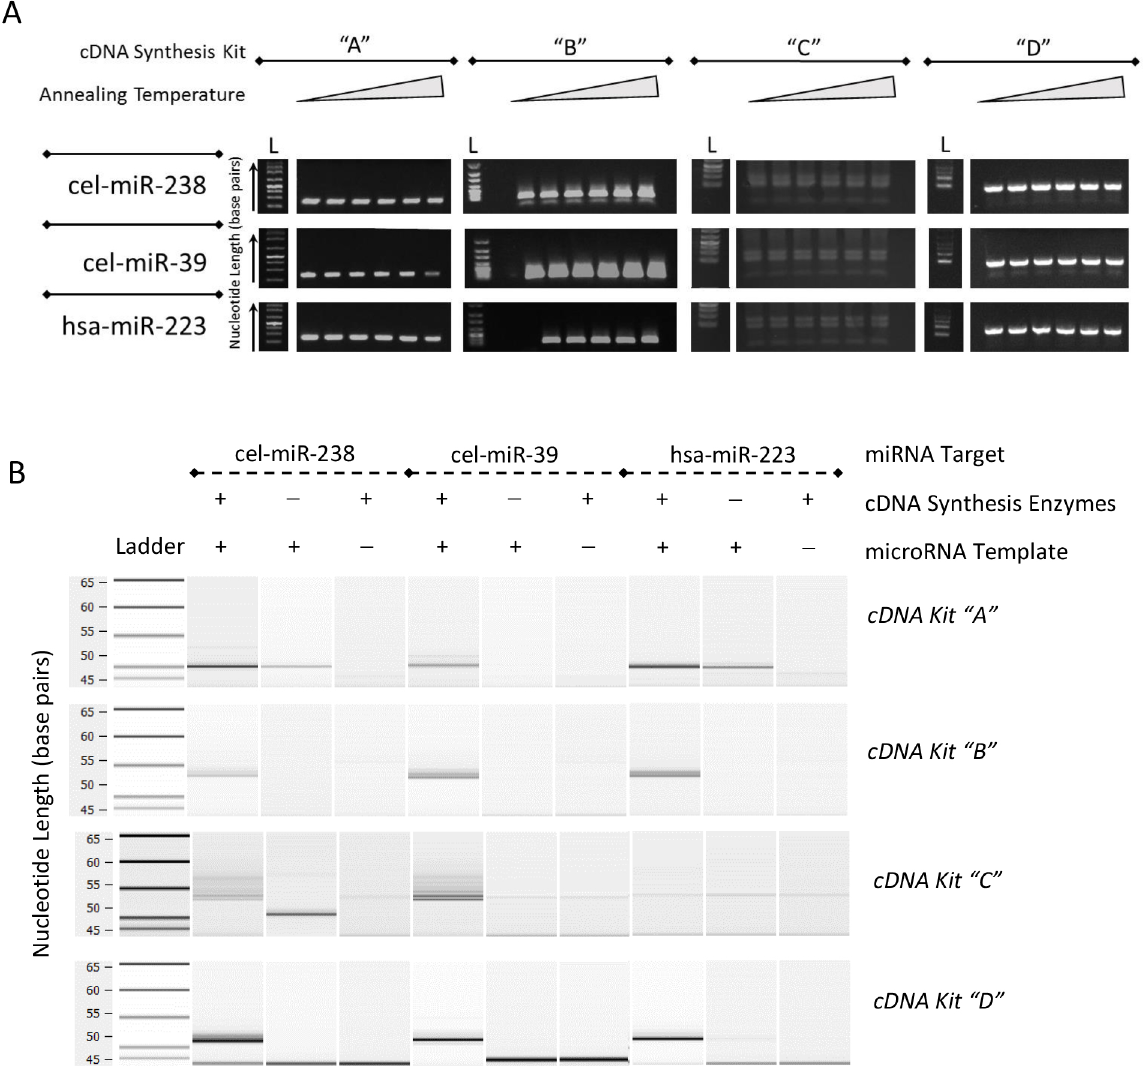
Fig 3. Annealing temperature evaluation using PCR. (A) Traditionalgel electrophoresis pictures after polymerasechain reaction (PCR) with increasing annealingtemperatures done after cDNA synthesis with cDNA Kits”A”, “B”, “C”, or “D”. (B) Chip-based automatedelectrophoresis system gel image of cDNA amplifiedusing PCR. Annealingtemperature rangesas indicatedper kit in degreeCelsius: cDNA Kit “A” = 52, 56, 58, 60, 62, 65; cDNA Kit “B” = 50, 52, 55, 58, 60, 62; cDNA Kit “C” = 50, 53, 56, 58, 60, 62; cDNA Kit “D” = 52, 56, 58, 60, 62, 65. “L” indicates a ladderlane. Synthetic oligonucleotide targets are listed on left by homologous